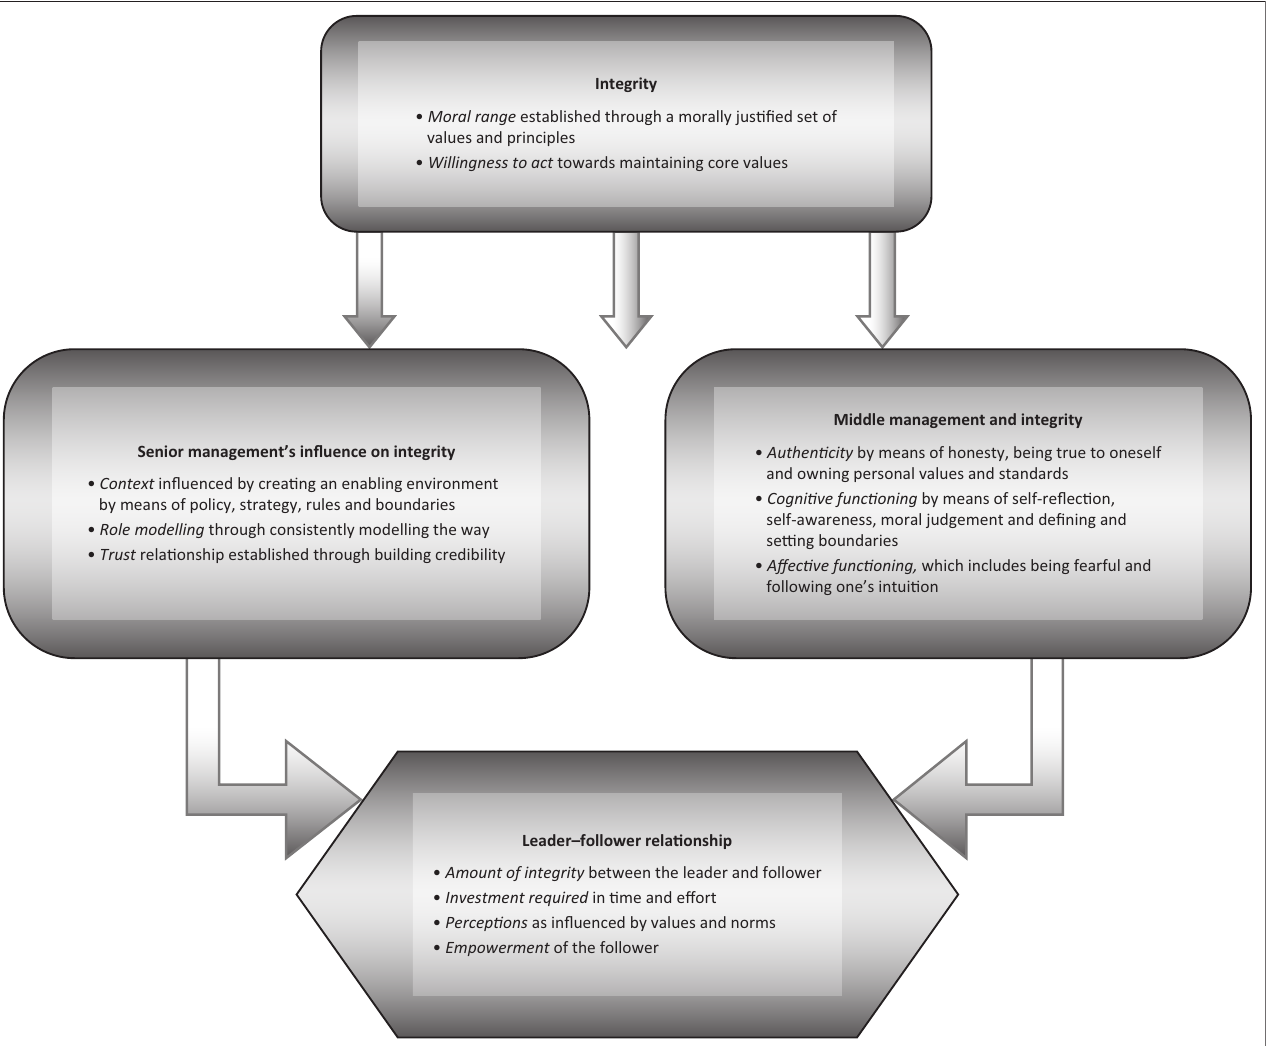
FIGURE 1: Middle managers’ experience of integrity, as impacted on by senior